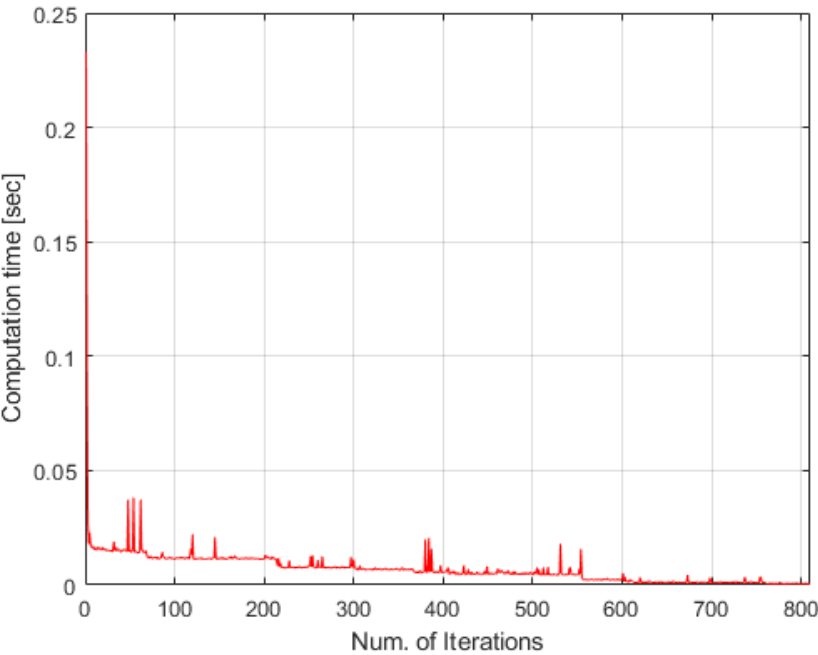
Figure 11. Computational time of TACTAR for a complicated case applying an accumulated distance cost scheme.